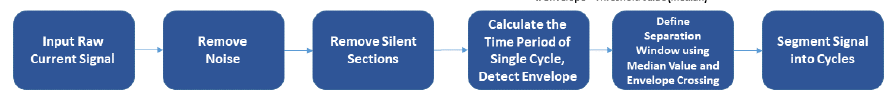
Figure 12. General block architecture of the segmentation method.